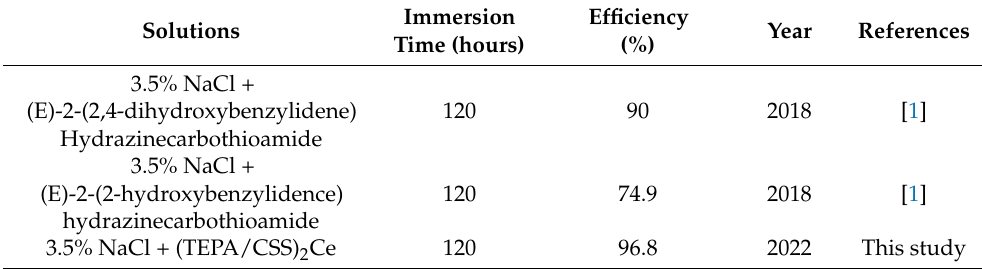
Table 5. Comparative corrosion inhibition efficiency of (TEPA/CSS) 2 Ce complex in this study with other corrosion inhibitors on AA2024-T3 in 3.5% NaCl. Immersion Efficiency Solutions Time (hours) (%)